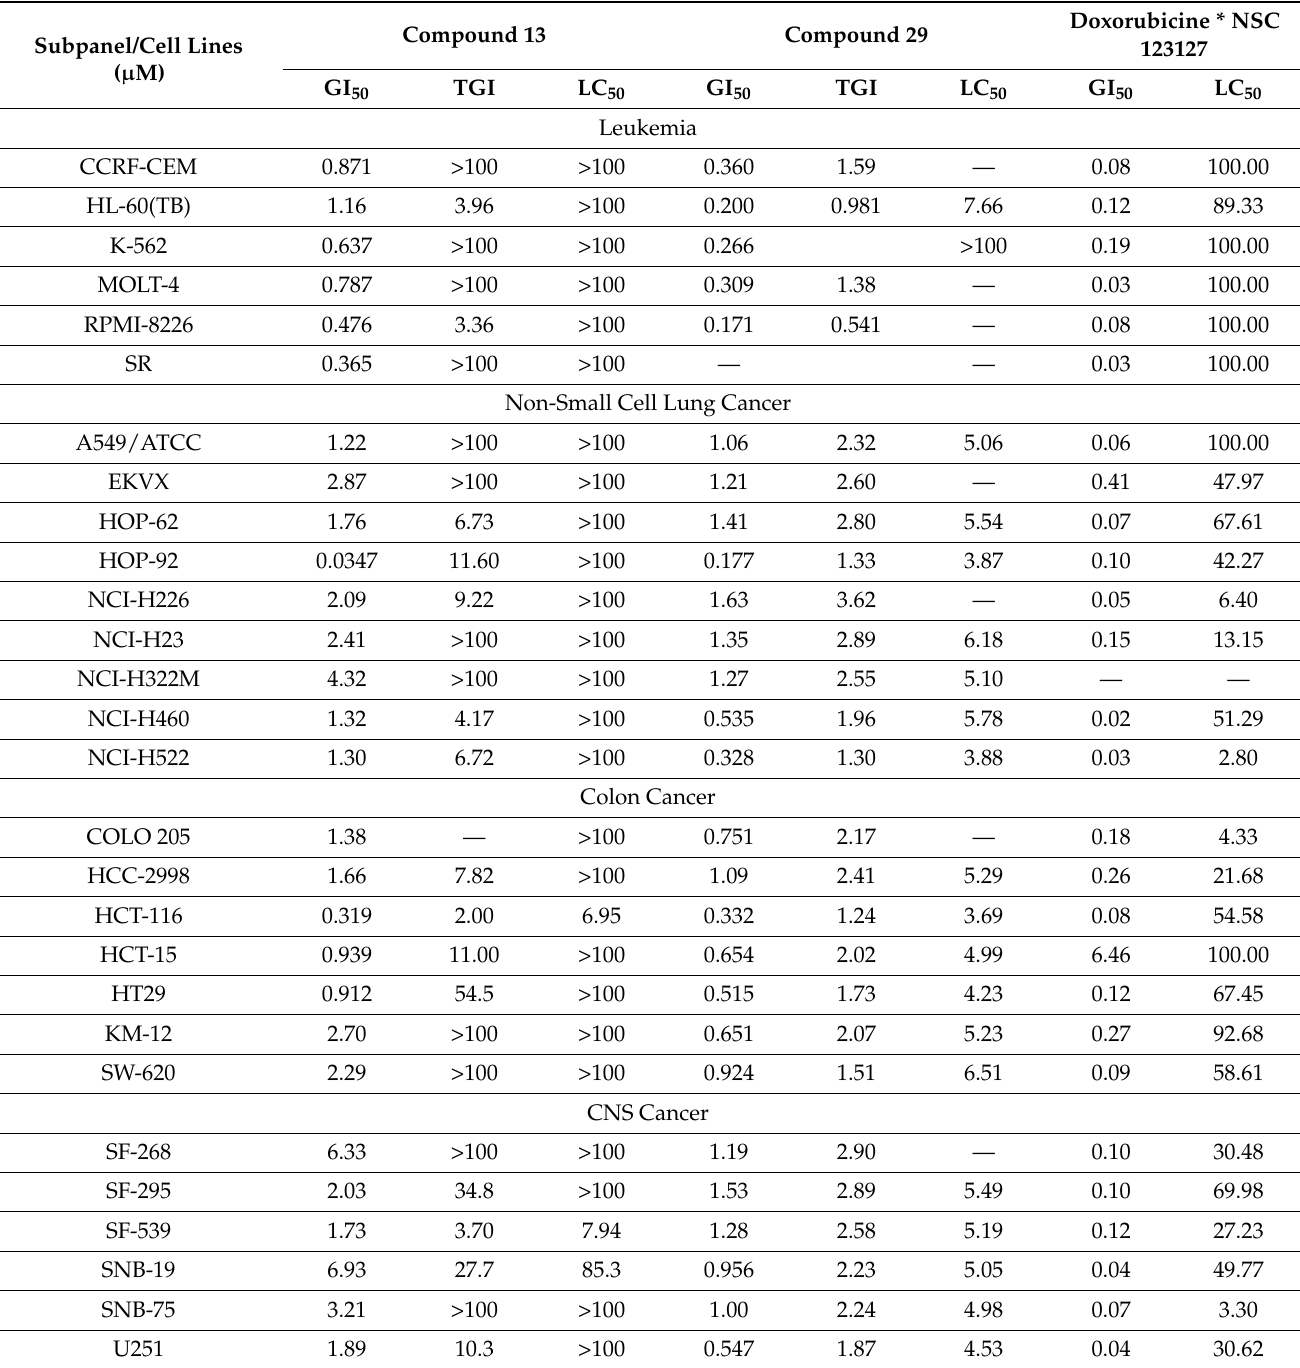
Table 3. In vitro anticancer activity of the most active compounds 13 and 29 against 60 human cancer cell lines in the second stage in single concentration 0.01–100 µ